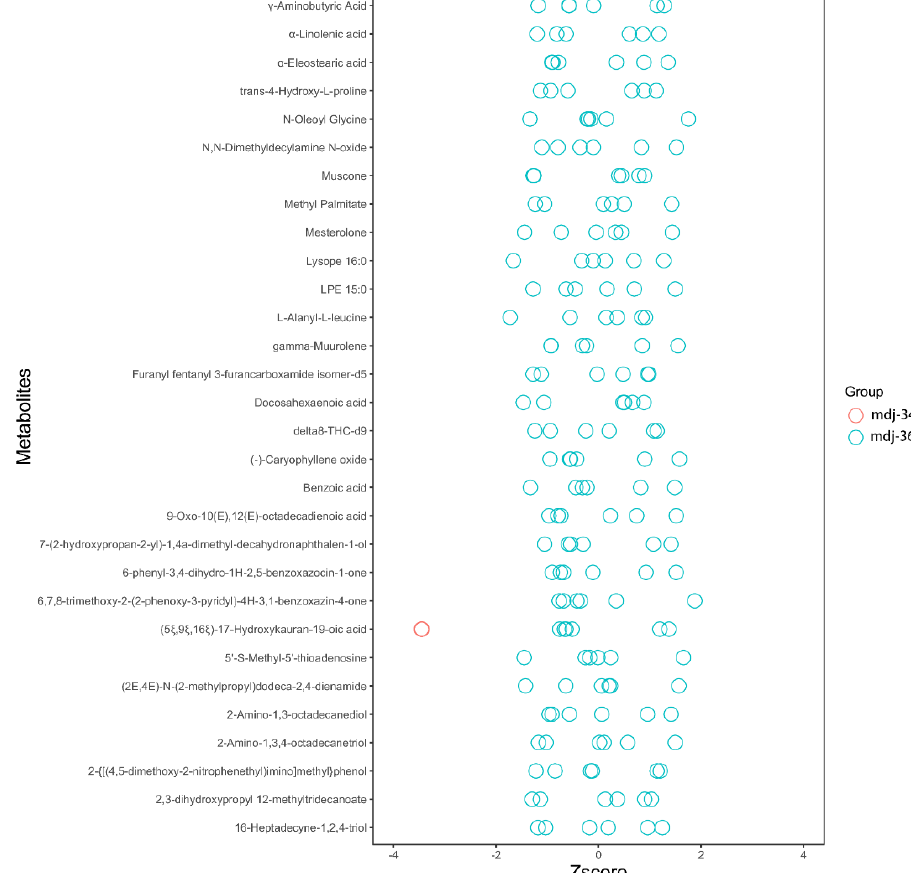
Figure 5. A plot comparing significantly different metabolites in the B. velezensis mdj_36 and mdj-34 growth media based on LC-MS/MS. The horizontal axis is Z-score, the vertical axis designates significantly-altered metabolites. The figure only shows the Top 30 significantly changed metabolites based on the Z-score value.